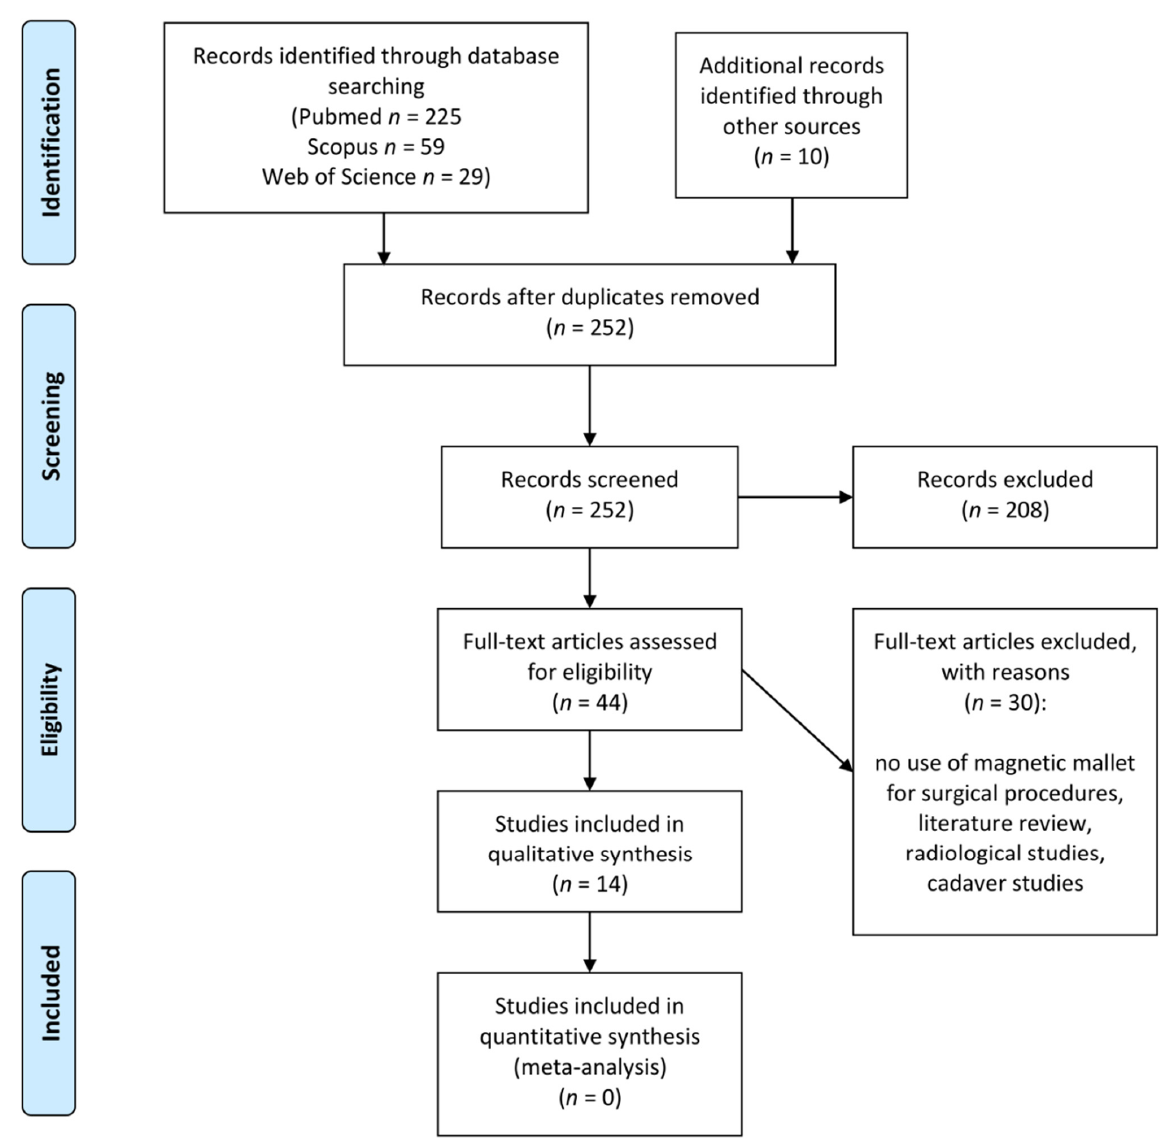
Figure 1. PRISMA flow diagram.